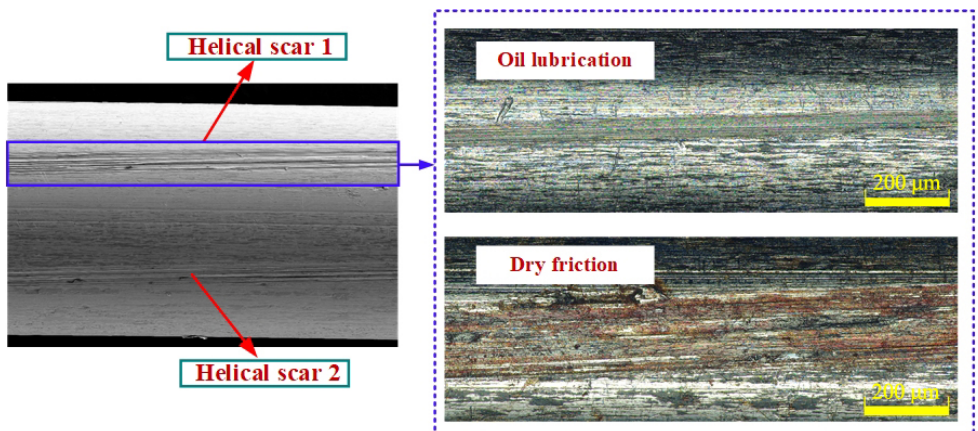
Fig. 18 Shapes of wear scars on steel wire